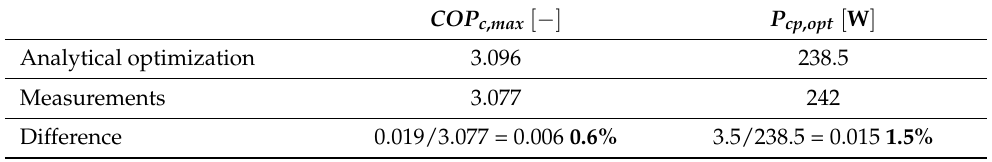
Table 2. Comparison of the results obtained by the analytical optimization or